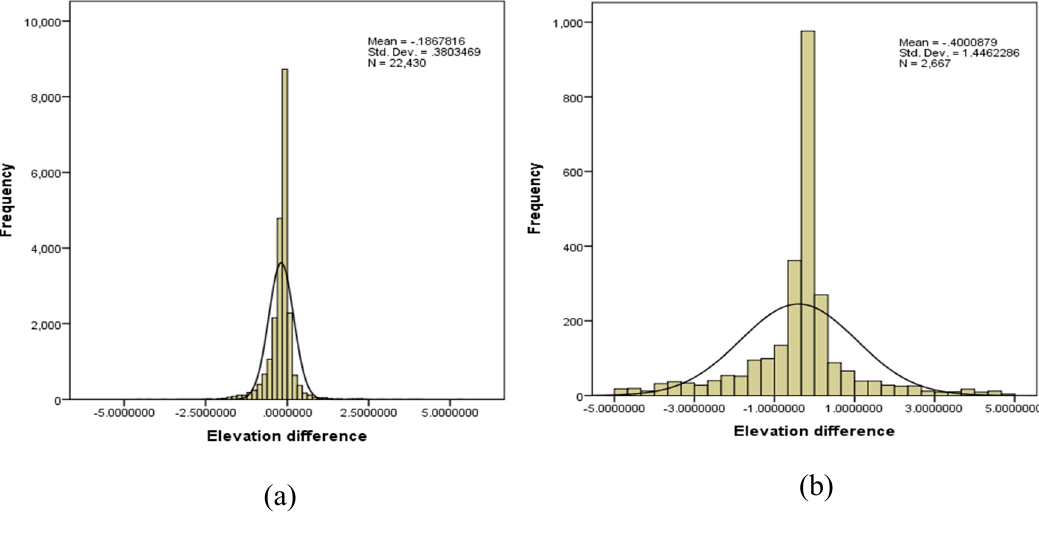
Figure 8. Derived DEMs in slant area by making supervised windows. ( a ) reference DEM, ( b ) DEM achieved in 3m rasterization process in slant area, ( c ) DEM achieved in 5 m rasterization process; ( d ) DEM difference between ( a ) and ( b ), ( e ) DEM difference between ( a ) and ( c ).